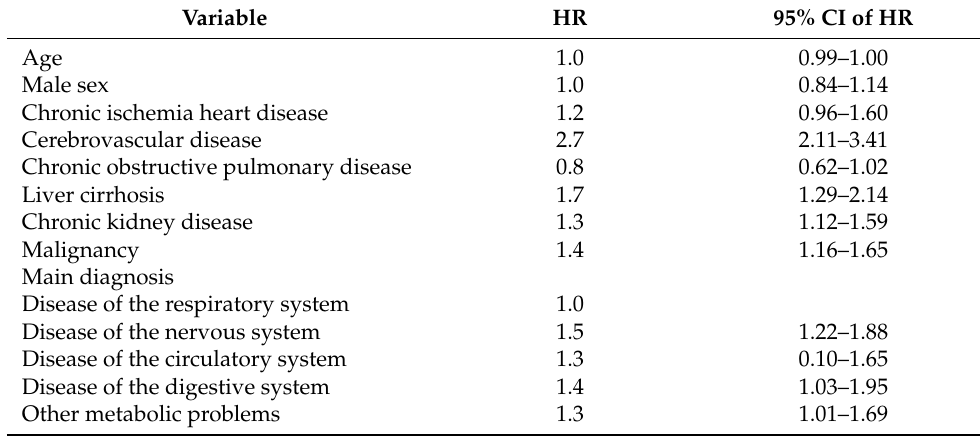
Figure 1. The 30-day mortality rate of different etiology with and without DNR after 1:4 propensity score matching. Table 3. Predictors of mortality in patients with DNR